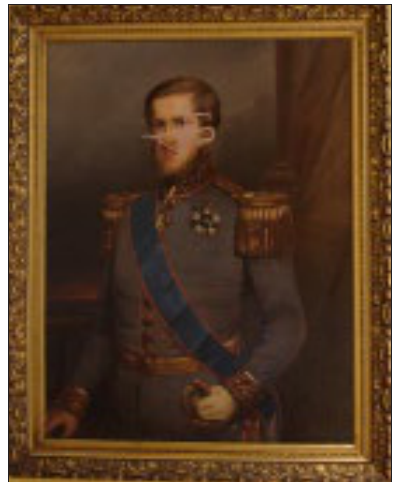
Figure 3: Portrait of Peter II on display at Museu Histórico Nacional , Rio de Janeiro, Brazil. Oil on canvas, 115 × 88